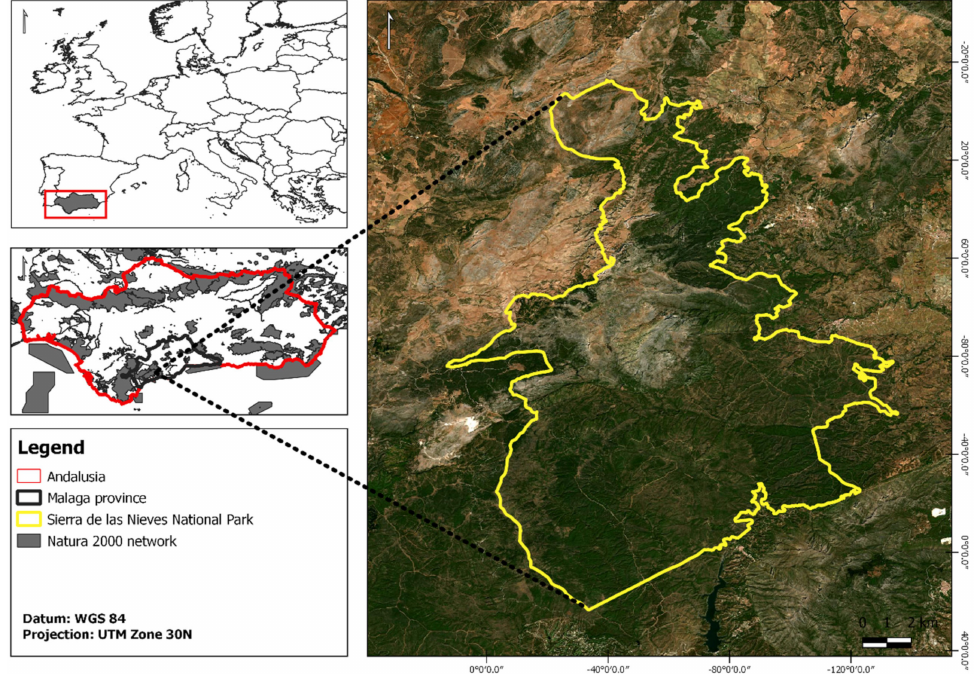
Figure 1. Location of the study area. Enlarged figure shows the limits of the Sierra de las Nieves National and Natural Park. A map showing the Natura 2000 network in Andalusia (left bottom inset, grey